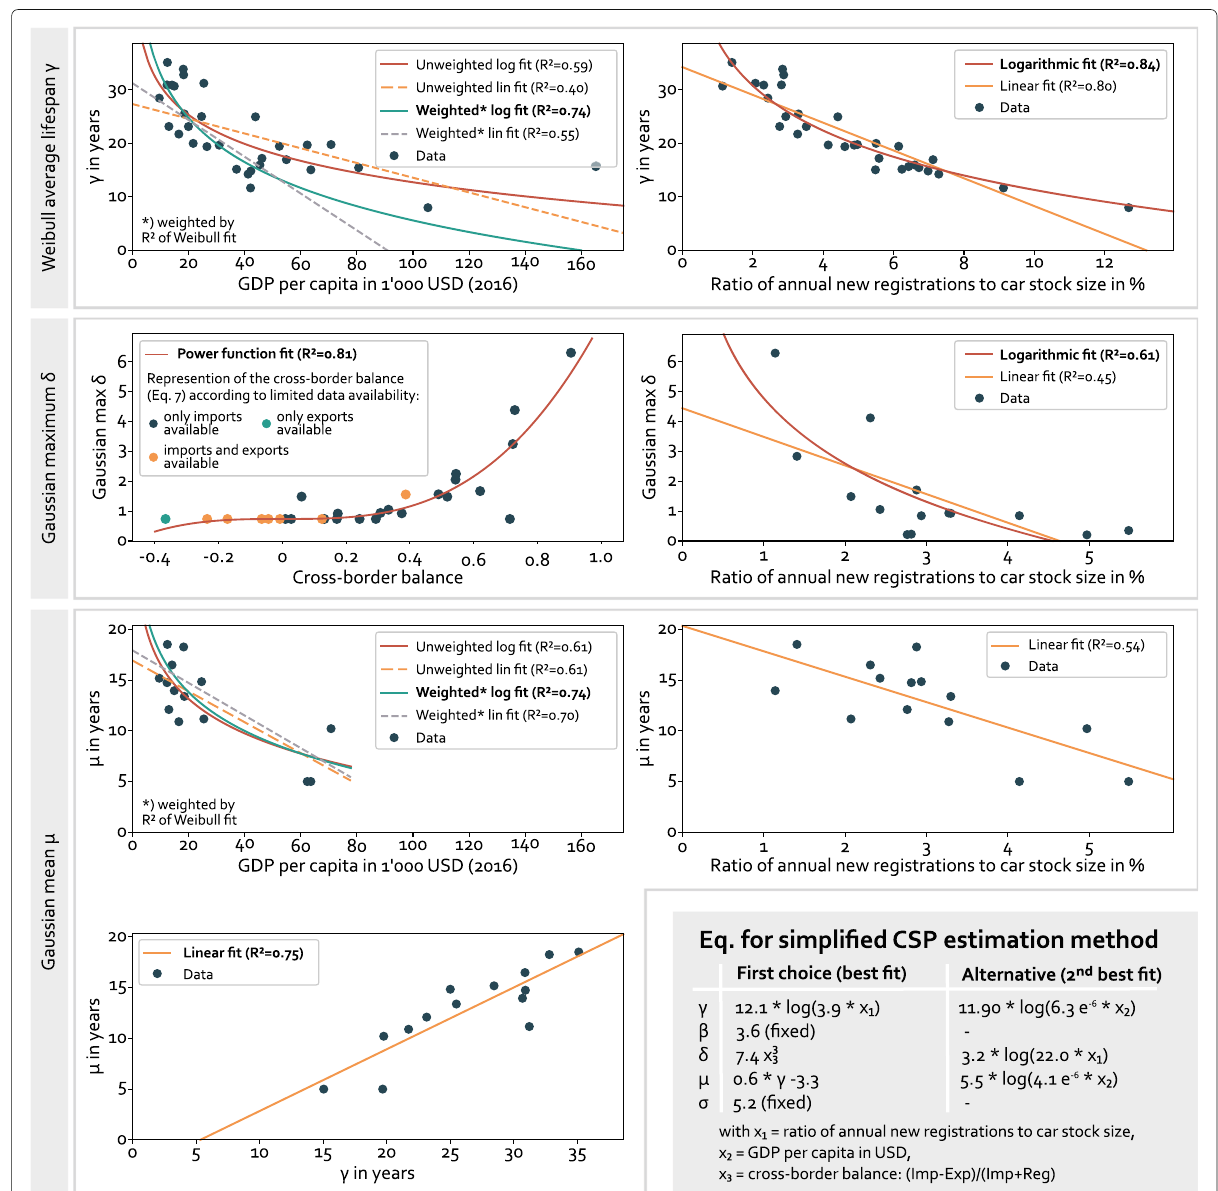
Fig. 6 Simplified CSP estimation method. Approximation of fitting parameters by aggregate indicators of a country – equations are given for best fits which are marked in bold in the corresponding plots. Fitting parameters refer to Eqs. 2 and 3